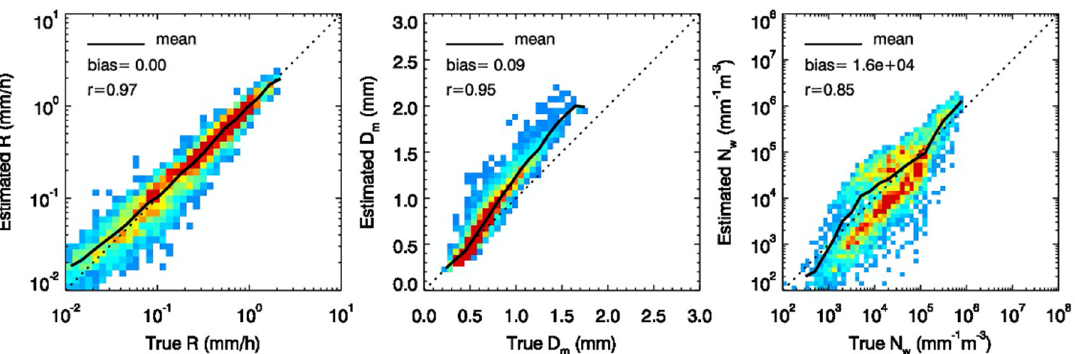
Figure 4. Comparison of the estimates in R ( left column), D m ( middle column), and N w ( right col- umn) from DFR with their true values. The scattering table with density of 0.1 g/cm 3 is used both for generating the PSD-based radar reflectivities and for the retrieval. A fixed µ = 3 gamma PSD model is assumed for the snow retrieval.